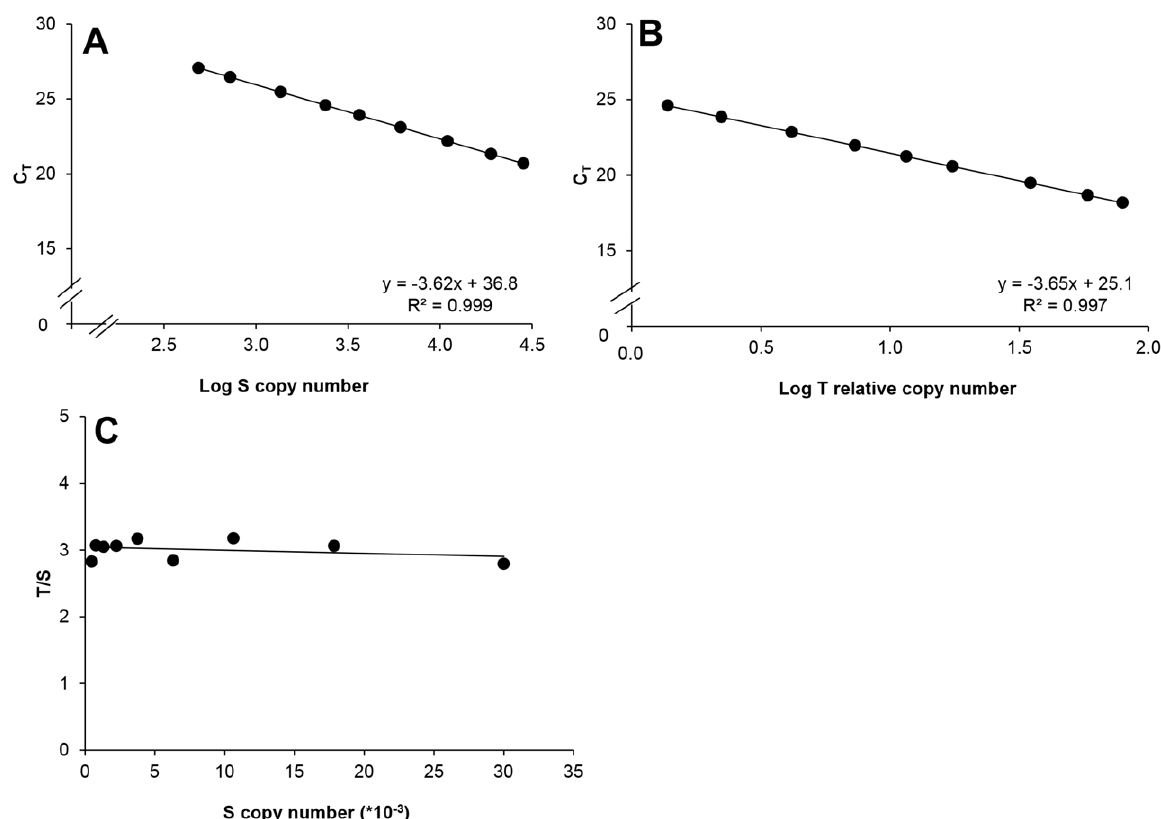
Figure 2. Standard curves used to determine T/S ratio. Pooled blood DNA was serially diluted (1:2) to generate nine DNA standards for the ASPG accessory gene (S) (panel A) and the telomere region (T) (panel B). Stability of the T/S ratio within the range of DNA concentrations was tested (panel C). N=1 for each point.